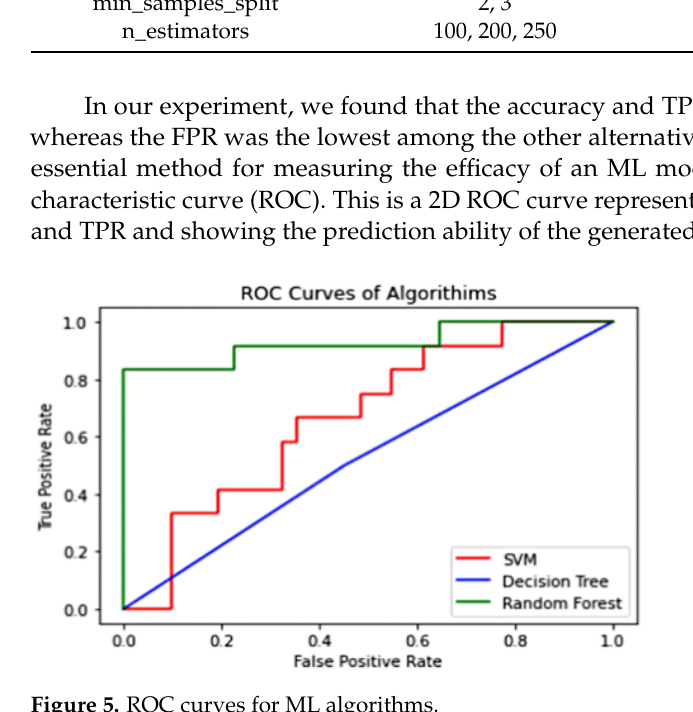
Figure 5. ROC curves for ML algorithms.